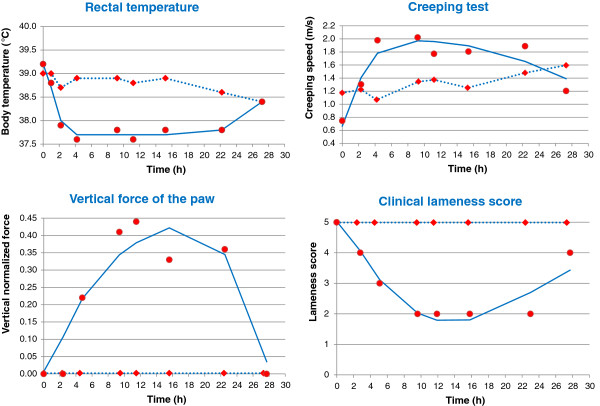
Observed ( ● ) and PK/PD predicted (-) effects of cimicoxib vs. time (h) after an oral administration of cimicoxib at 2 mg/kg and observed ( ♦, ●●● ) effects of placebo vs. time (h) for 4 endpoints in a representative poor metabolizer dog. Predicted PK/PD effects were obtain by fitting PD data using an indirect effect model (see Methods for details), for lameness score from 0 (no lameness) to 5 (maximal lameness), see Figure 3 for a definition of the different scoring.